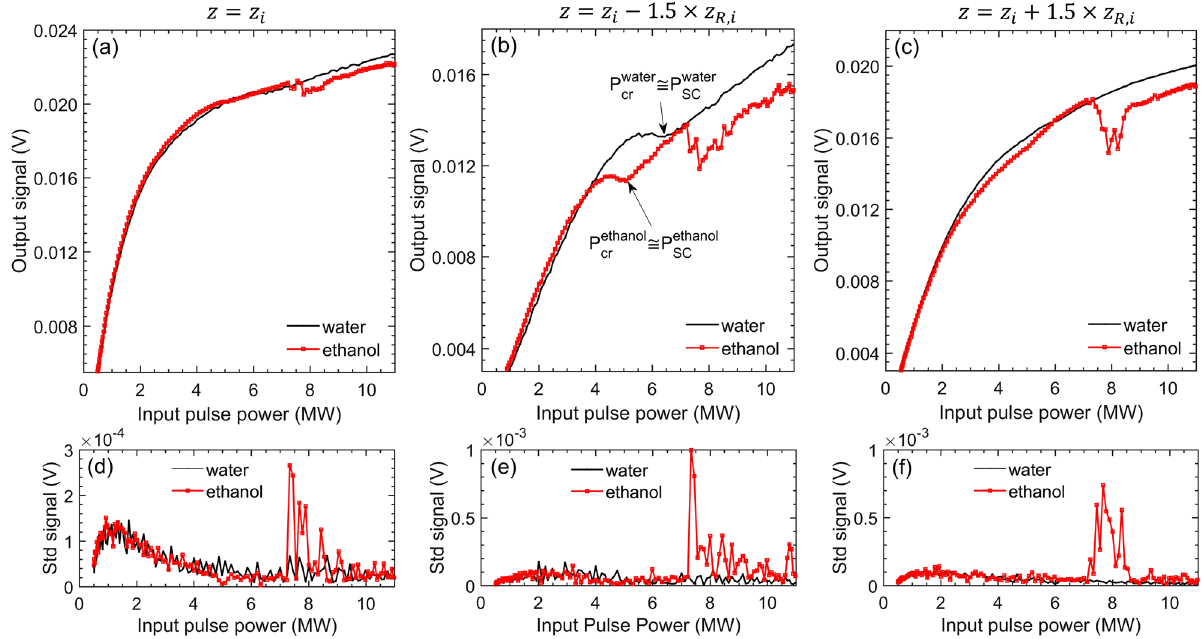
Figure 1. Typical experimental measurements in deionized water (black solid lines) and ethanol (red solid lines) by the optical power limiter in the filamentation regime. The top figures (a–c) present the output signal averaged over 10 shots and the bottom figures (d–f) show the standard deviation of these measurements. Top and bottom figures (presented in column pairs) correspond to different locations of the pinhole: (a,d) z = z i , (b,e) z = z i − 1.5 × z R,i and (c,f) z = z i + 1.5 × z R,i . Distinct features related to collapse of the beam